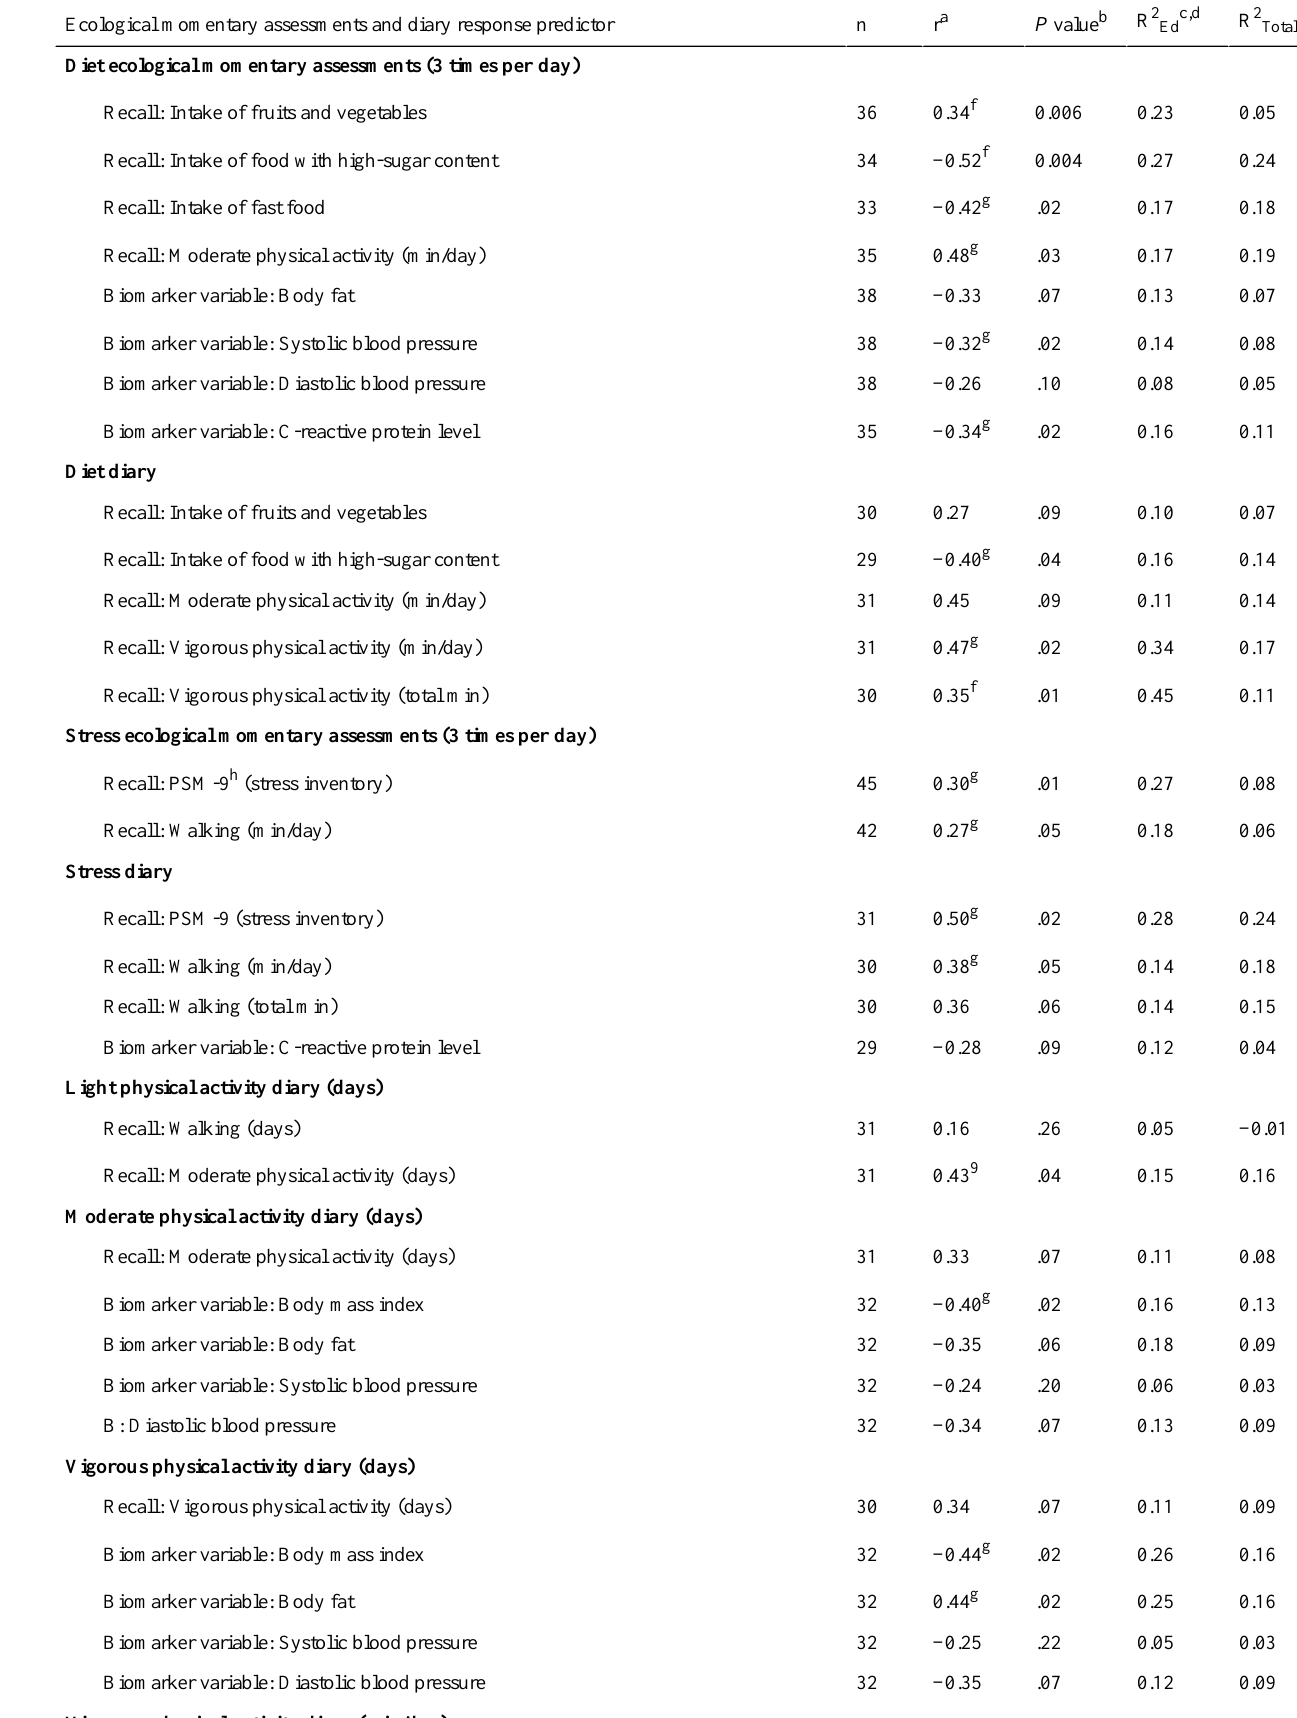
Table 1. Linear relationships between the pairs of ecological momentary assessments or daily diary